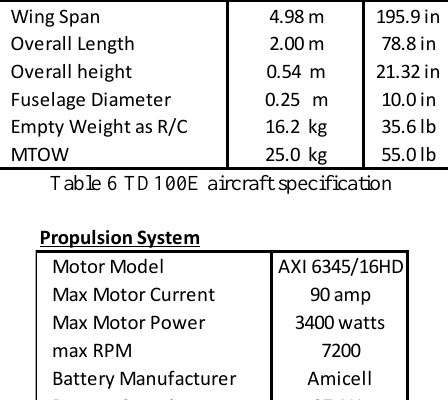
Figure 9: TD100 search pattern